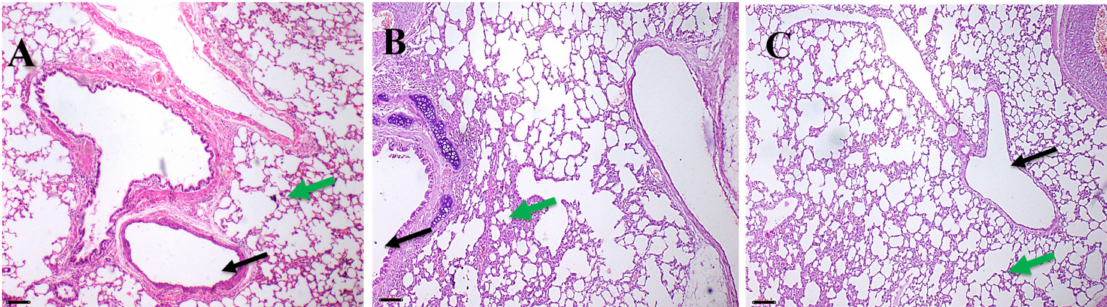
Figure 9. Representative photos of H and E stained photomicrographs of lung for one representative rabbit after irritation test for ( A ) Group I; untreated group, act as a control, ( B ) Group II; rhamnolipids nano-micelles solution dispersed in PBS (10 mM, pH 7.4) treated group, and ( C ) Group III; PBS (10 mM, pH 7.4) treated group. All groups treated with samples showed normal histological tissue identical to untreated group after 72 h of treatment with samples. Black arrows pointed to bronchioles while green arrows pointed to alveolar cells. Scale bar, 50 µ m.